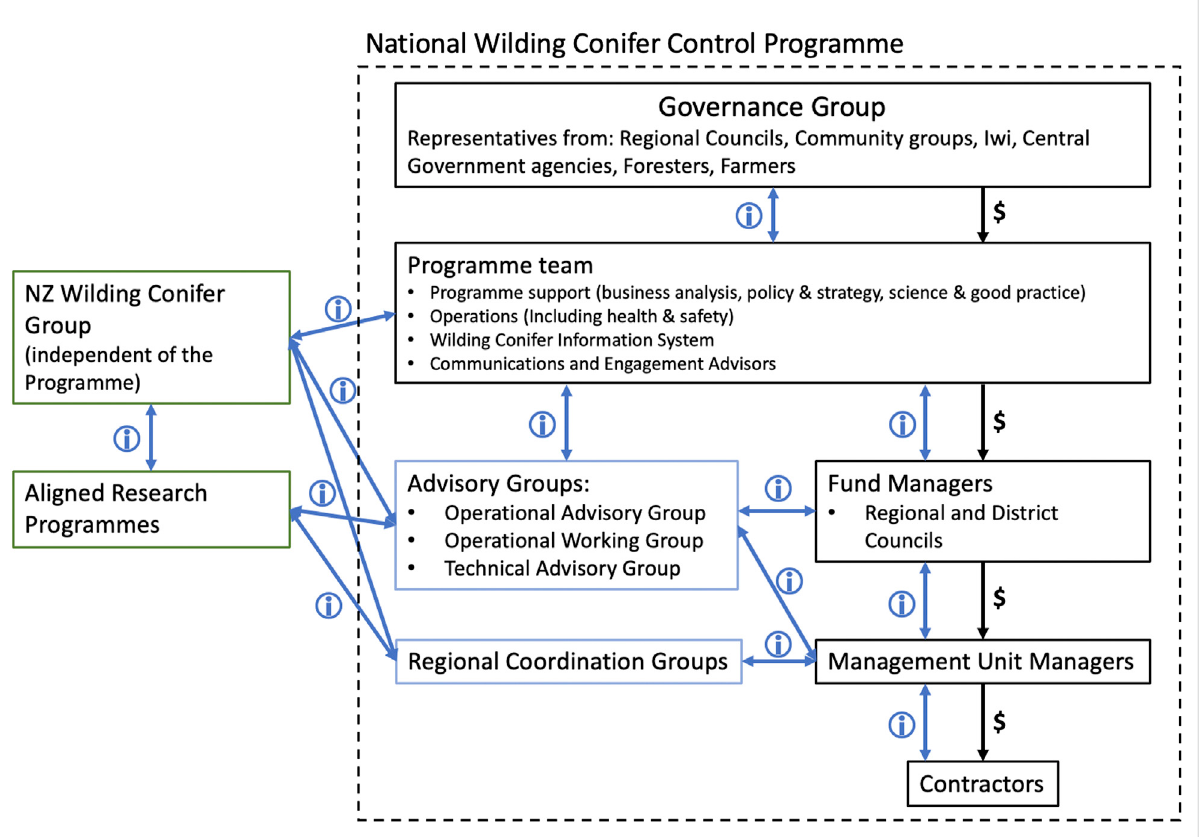
FIGURE 2 StructureoftheProgramme,showingtheoperationaldeliverystructure(rightsideofthe fi gure)andthe fl owofinformationandadvice(leftside of the fi gure). Allocation of funding (black arrows) fl ows from the Governance Group through to contractors. Information and advice (blue arrows) fl ows between all groups through regular meetings and workshops, enabling members of the Programme to raise and respond to potential challenges quickly. The membership and roles of each of the groups are described in Table